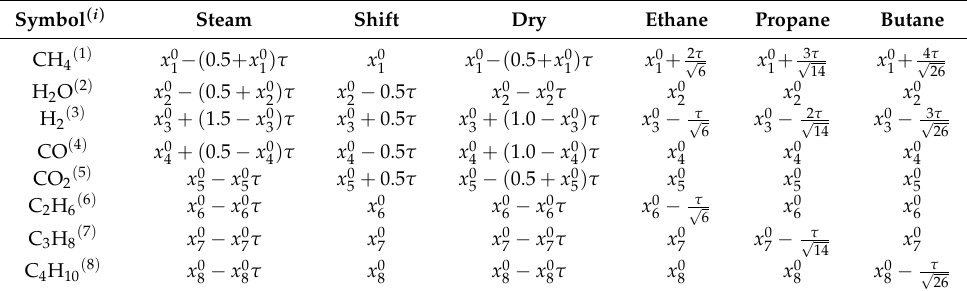
Table 1. Change of mole fraction in the